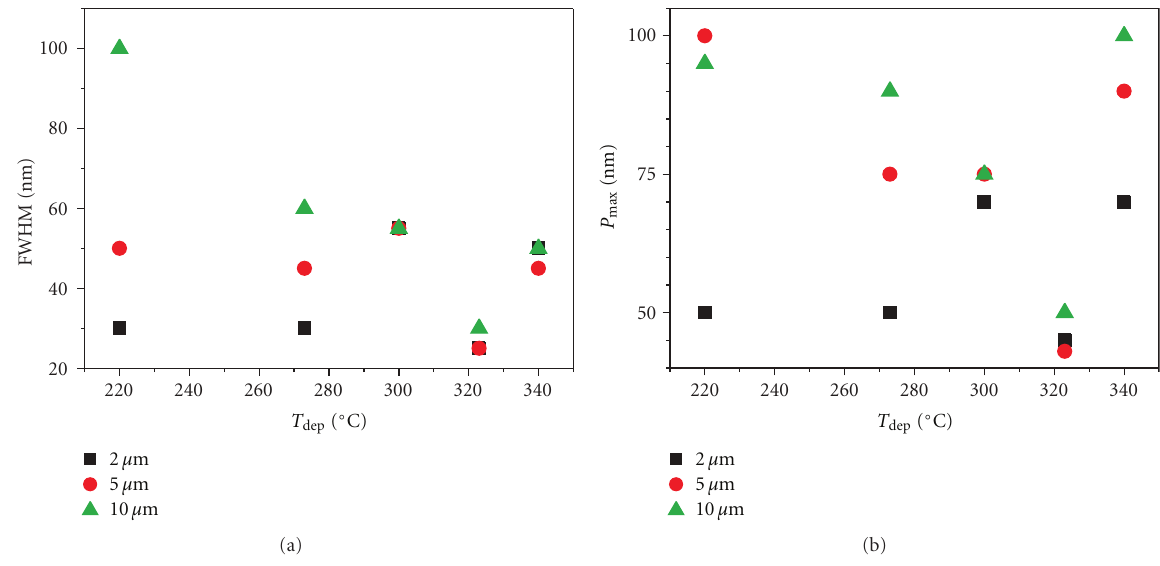
Figure 6: Deposition temperature dependence of height distribution parameters: (a) full widths at half maximum (FWHM) and (b) peak maximum ( P max ) of In 2 S 3 films evaluated on di ff erent scales (2 × 2 μ m 2 , 5 × 5 μ m 2 , and 10 × 10 μ m 2